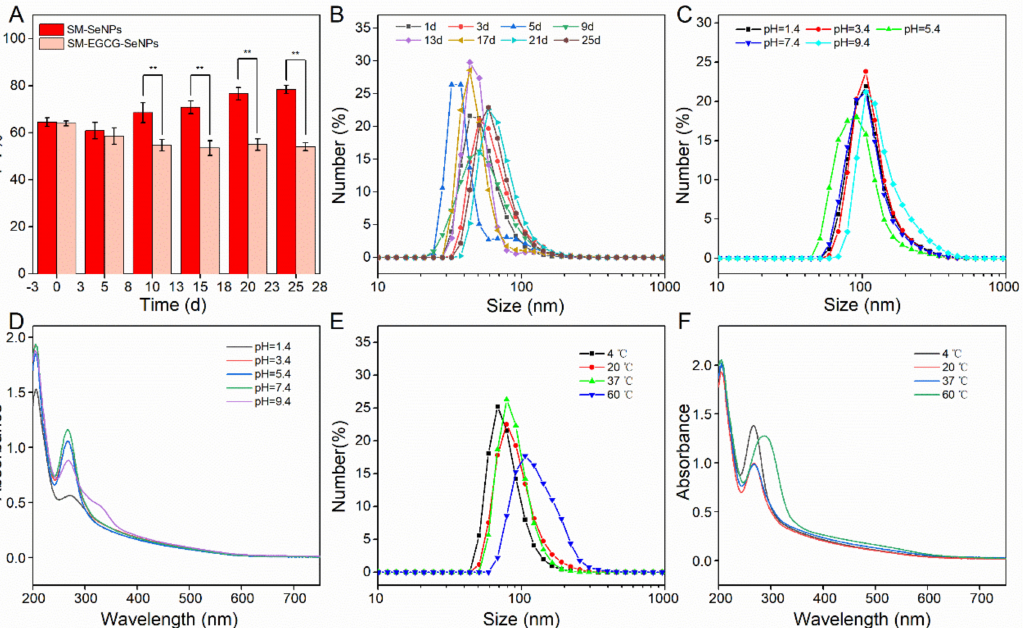
Figure 2. Characterization of SeNPs system. ( A ) Turbidity changes of SM-SeNPs and SM-EGCG- SeNPs. ( B ) Particle size variation in SM-EGCG-SeNPs during storage. Changes in ( C ) particle size and ( D ) UV-vis absorption spectra of SM-EGCG-SeNPs versus pH values. Changes in ( E ) particle size and ( F ) UV-vis absorption spectra of SM-EGCG-SeNPs versus temperature. The difference between groups is indicated at ** p <